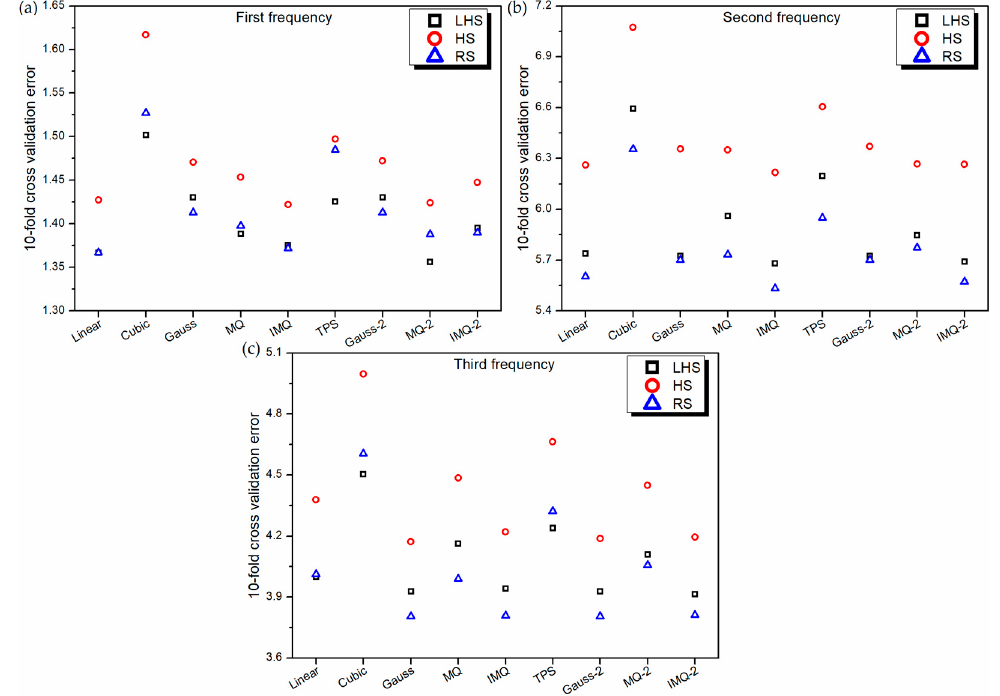
Figure 9. 10-fold cross-validation error of various RBF metamodels in HD-problem.